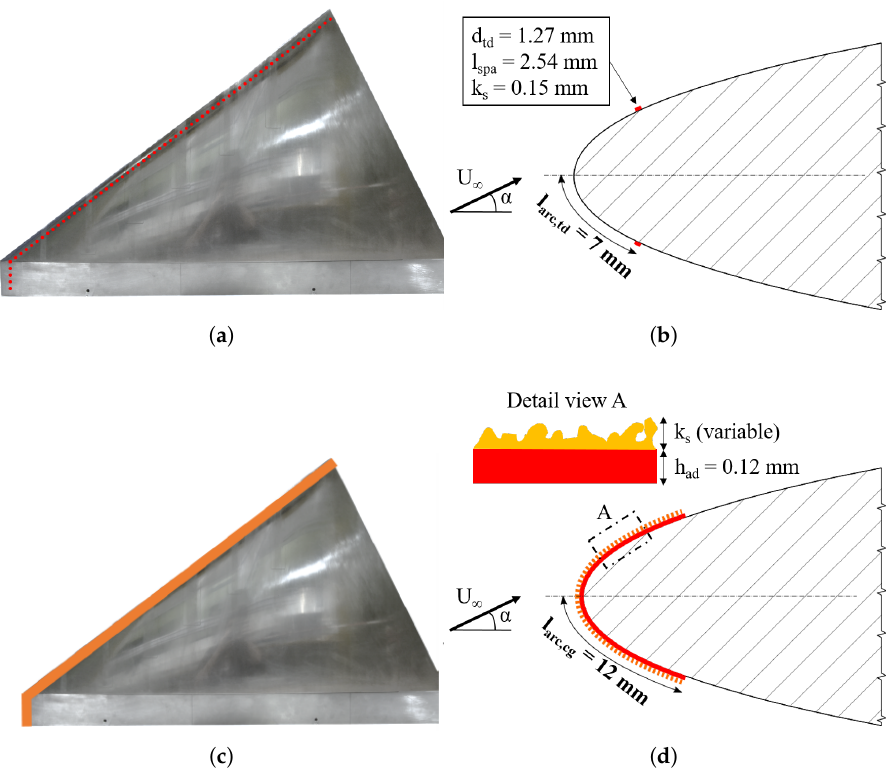
Figure 2. Geometric parameters of the applied trip strips. ( a ) Trip dot type, overview; ( b ) Trip dot type, leading-edge sectional view; ( c ) Carborundum grit type, overview; ( d ) Carborundum grit type, leading-edge sectional